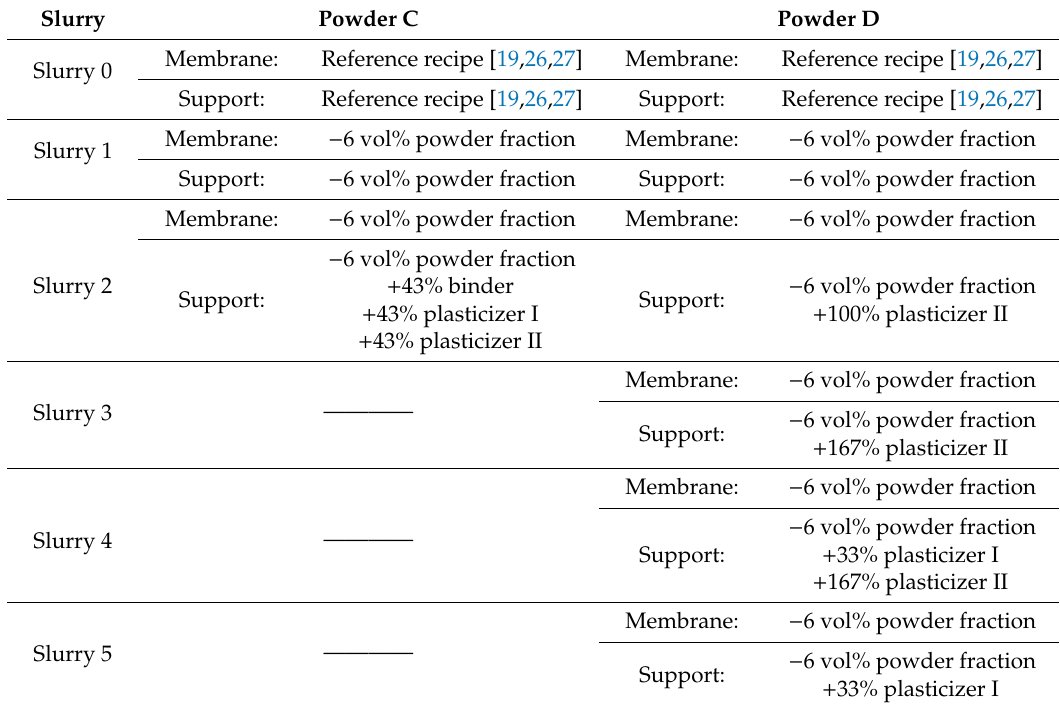
Table 3. Composition of the di ff erent slurries prepared using LSCF powders C and D. Slurry Powder C Powder D Slurry 0